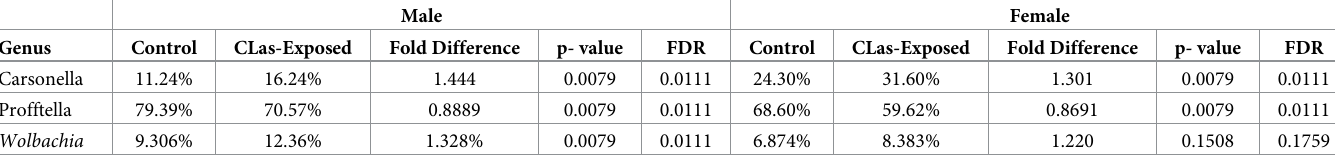
Table 1. Relative abundance of the predominant genera in male and female adults. The median relative abundance (as percentage) was compared between control and CLas-exposed groups for males and females, and significant differences determined using the Mann-Whitney U two-tailed test with an FDR of 5%. The median CLas rela- tive abundance was 0.13% in CLas-exposed males and 0.15% in CLas-exposed females. Male Female Genus Control CLas-Exposed Fold Difference p- value FDR Control CLas-Exposed Fold Difference p-